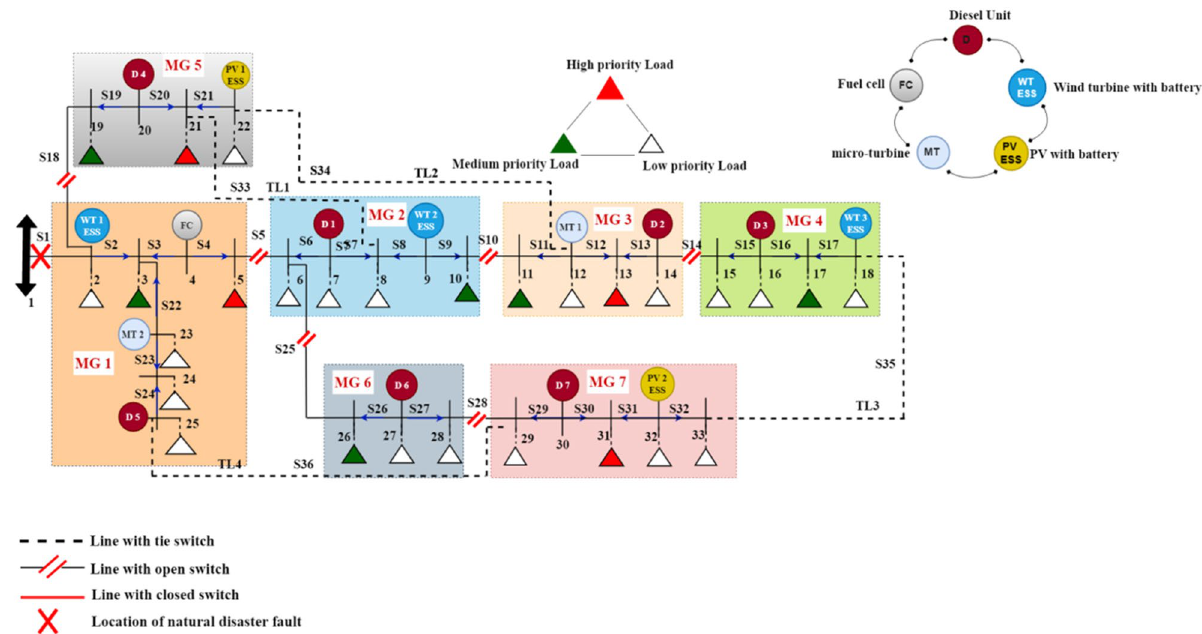
Figure 5. The optimal MG formation scenario without EDRP.